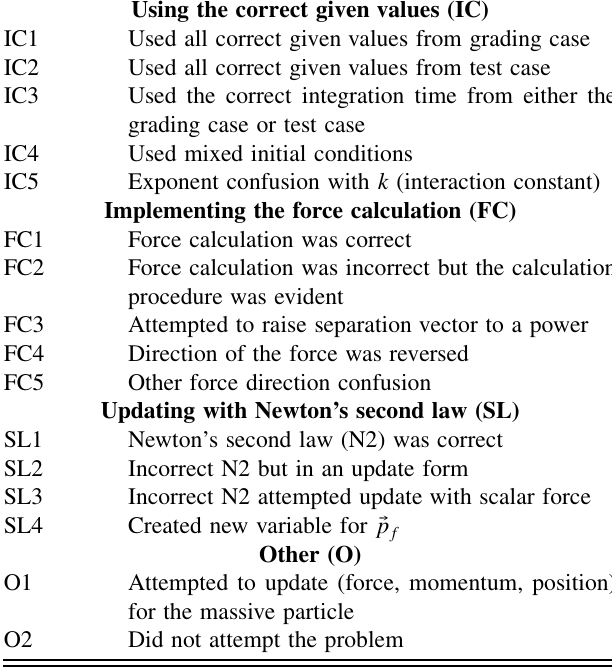
IMPLEMENTING AND ASSESSING . . TABLE II. Incorrectly written programs were subjected to an analysis using a set of codes developed from common student mistakes. The codes focused on three procedural areas: using the correct given values (IC), implementing the force calculation (FC), and updating with the Newton’s second law (SL). We reviewed each of the incorrectly written student programs for each of the features listed below. These codes are explained in detail in the appendix.